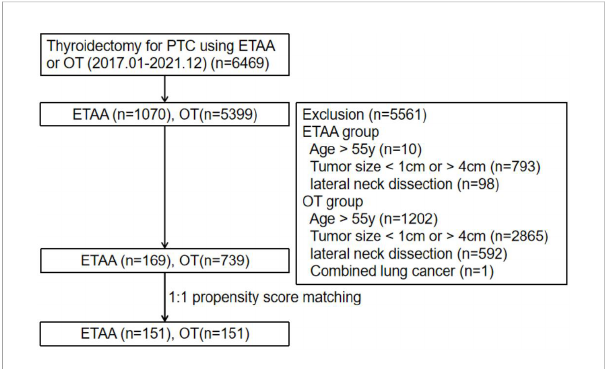
FIGURE 1 Study fl owchart. ETAA, endoscopic thyroidectomy via areola approach; OT, open thyroidectomy; PTC, papillary thyroid